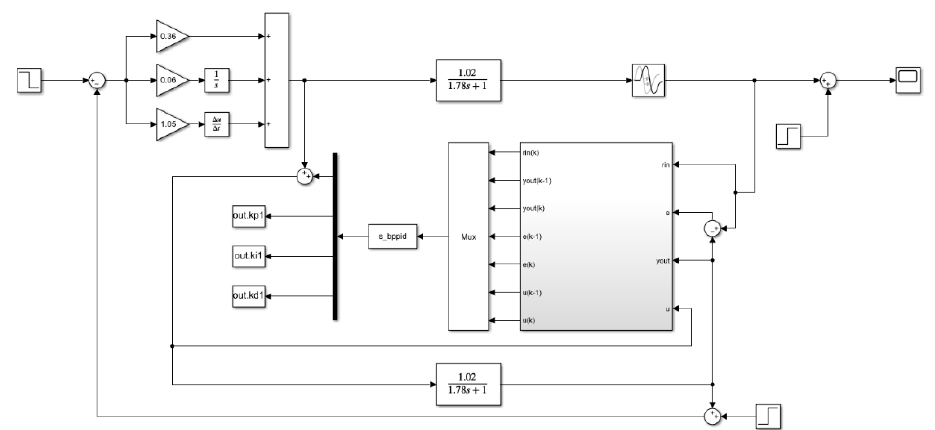
Figure 10. Simulation model of pH regulation system based on BP-PID-Smith prediction compensation.